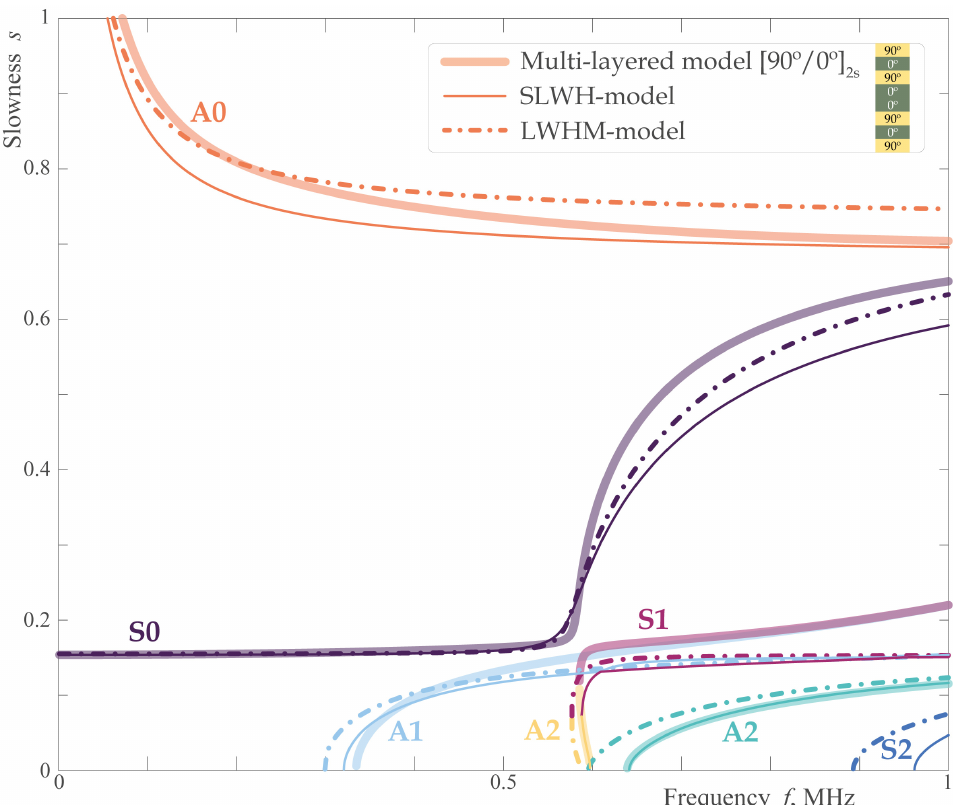
Figure 5. Slownesses s n ( f ) for [ 90 ◦ ,0 ◦ ] 2s : multi-layered waveguide (thick solid lines), homogenized waveguides (dashed and thin solid